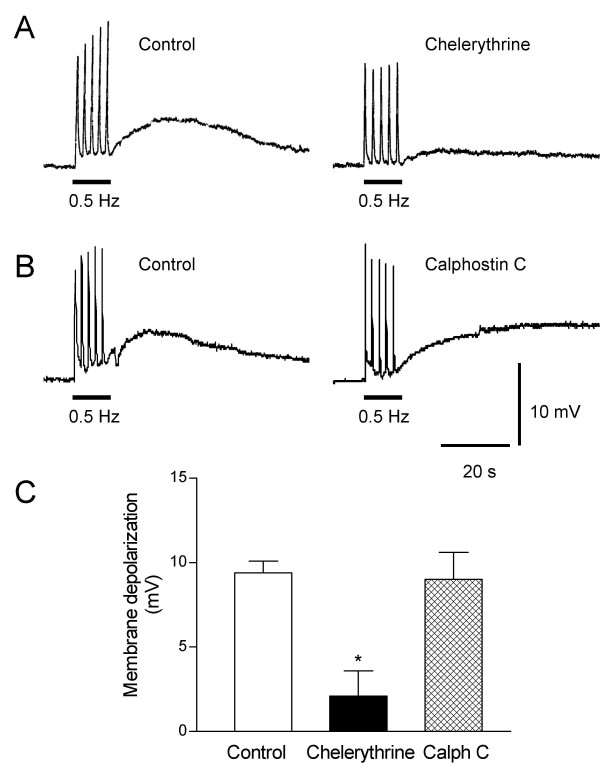
The PKC inhibitor chelerythrine, but not calphostin C, reduces the EFS-evoked slow membrane depolarization in canine isolated mesenteric vein. Intracellular recordings of membrane potential in response to EFS (0.1 ms, 13V, 10 s, 0.5 Hz) in control mesenteric veins (Control) or in tissues preincubated for 60 min with 1 μM chelerythrine (A) or 10 μM calphostin C (Calph C, B). The experimental data are presented as mean ± SEM, n = 3. *, P < 0.05 versus control. Scale bars apply to traces A and B.